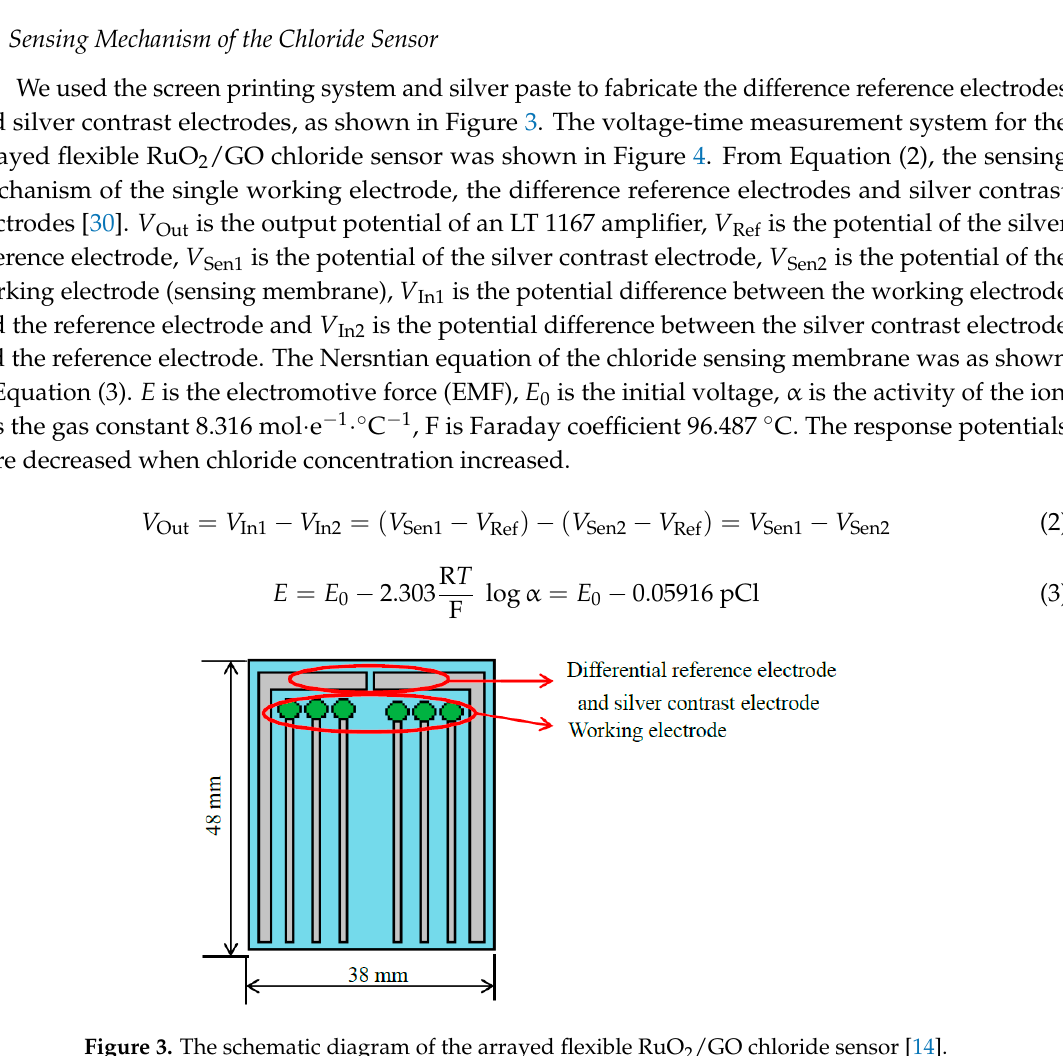
Figure 2. The fabrication process of the arrayed flexible RuO 2 /GO chloride ion sensor